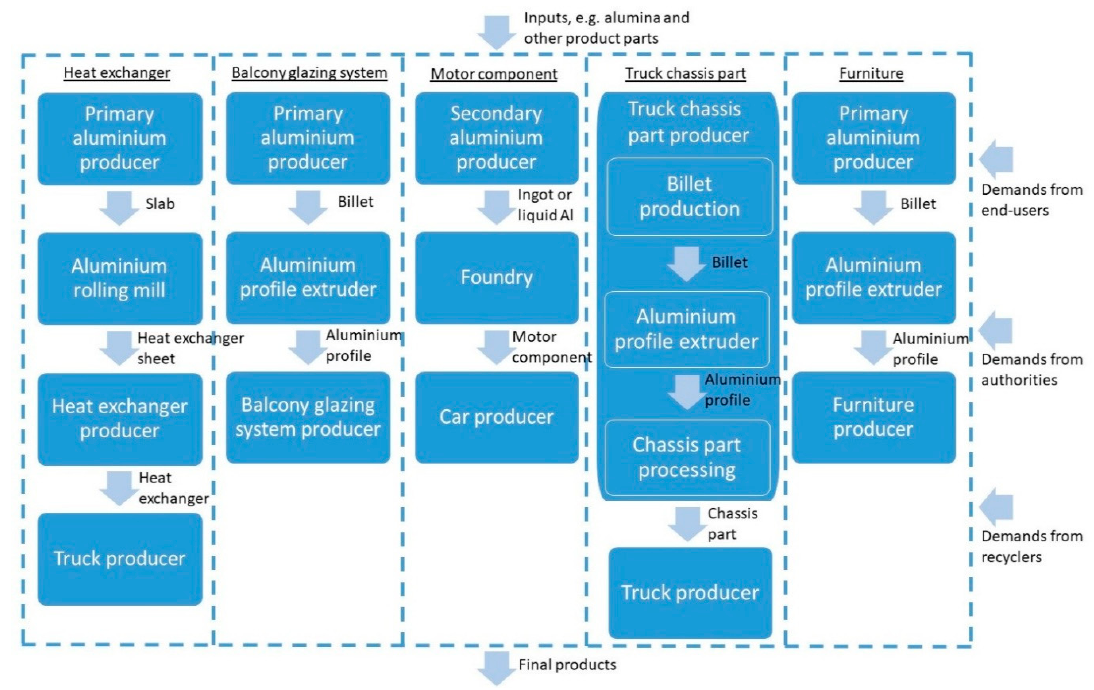
Figure 1. The supply chains studied in the article and the chosen system boundary.